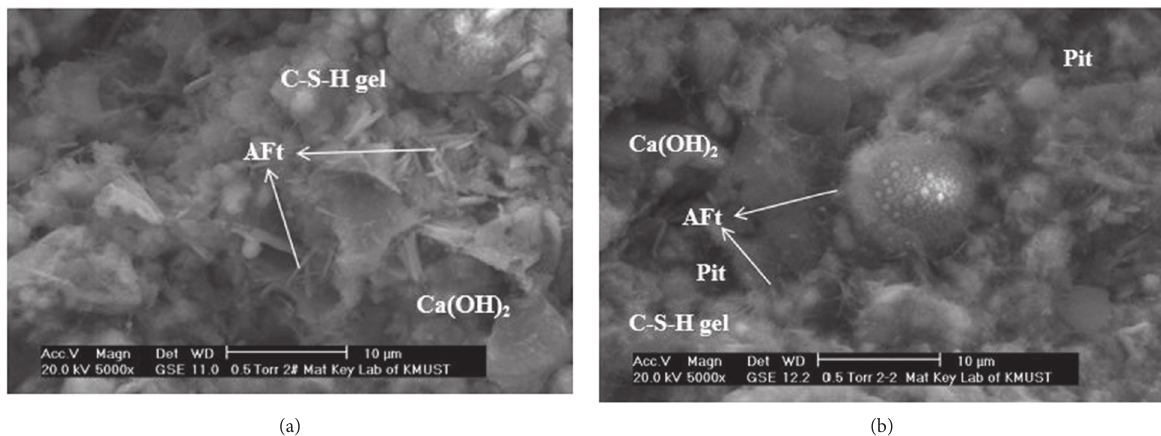
Figure 5: Microstructure of cementitious body after 3 days and 28 days with 50% fly ash and activator. (a) 3 d curing period; (b) 28d curing period.